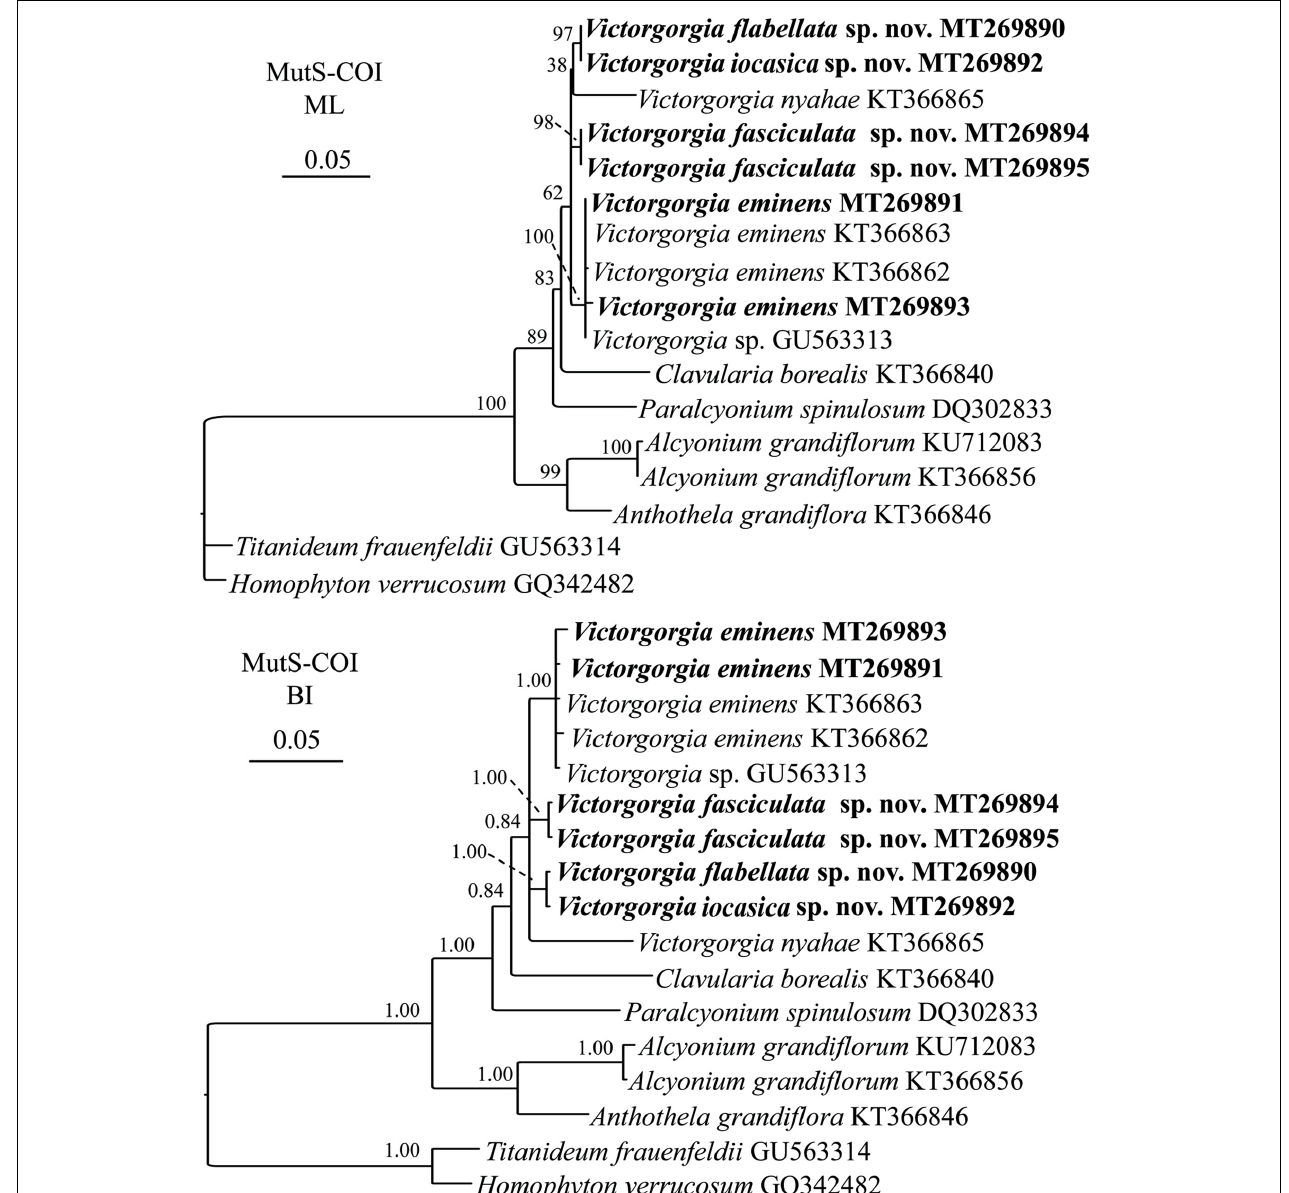
FIGURE 13 | Maximum likelihood (ML) and Bayesian inference (BI) trees based on concatenated sequences mtMutS-COI showing phylogenetic relationships among the available Victorgorgia species. Newly sequenced species are in bold.